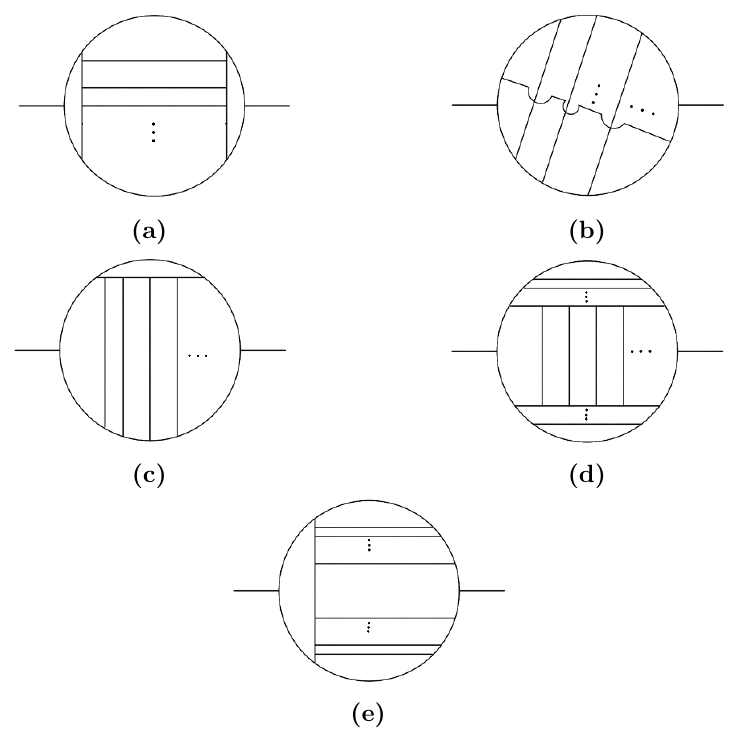
Figure 11. Non-trivial vanishing quantum corrections to self-energies at generic loop